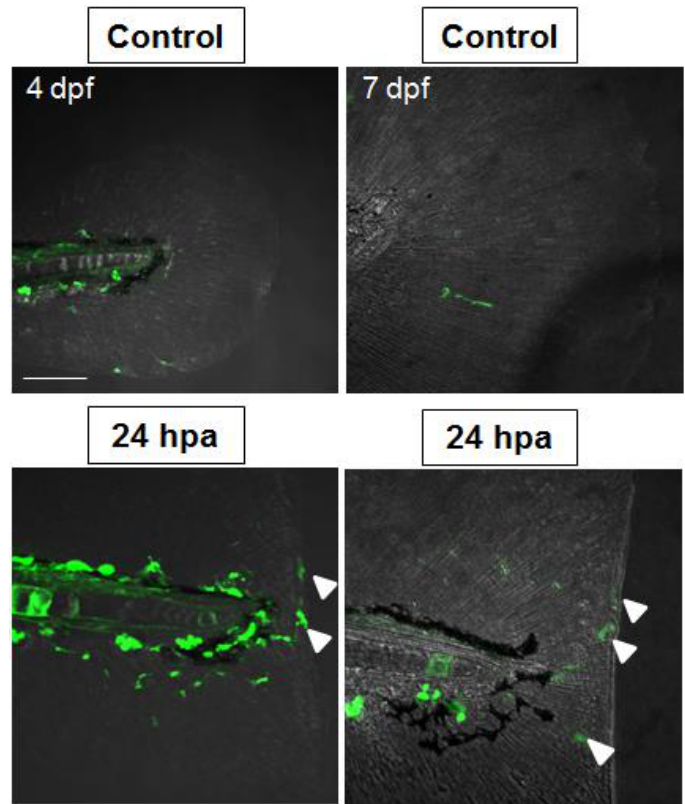
Figure 5. Nrf2/ARE pathway activity increases in regenerating tail fins. Representative Z-stack projection of a confocal fluorescence microscopy acquisition of unamputated and amputated tail fin of representative 4 dpf and 7 dpf Nrf2/ARE transgenic fish after at 24 h post amputation (hpa), showing fluorescent cells migrating along the stump (white arrowheads). Scale bar: 100 μ m.